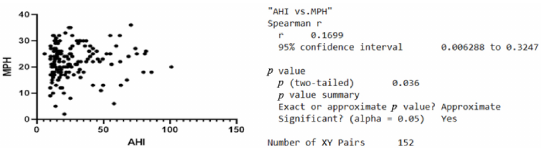
Figure 2. Graphic representation of the correlation between MPH values and